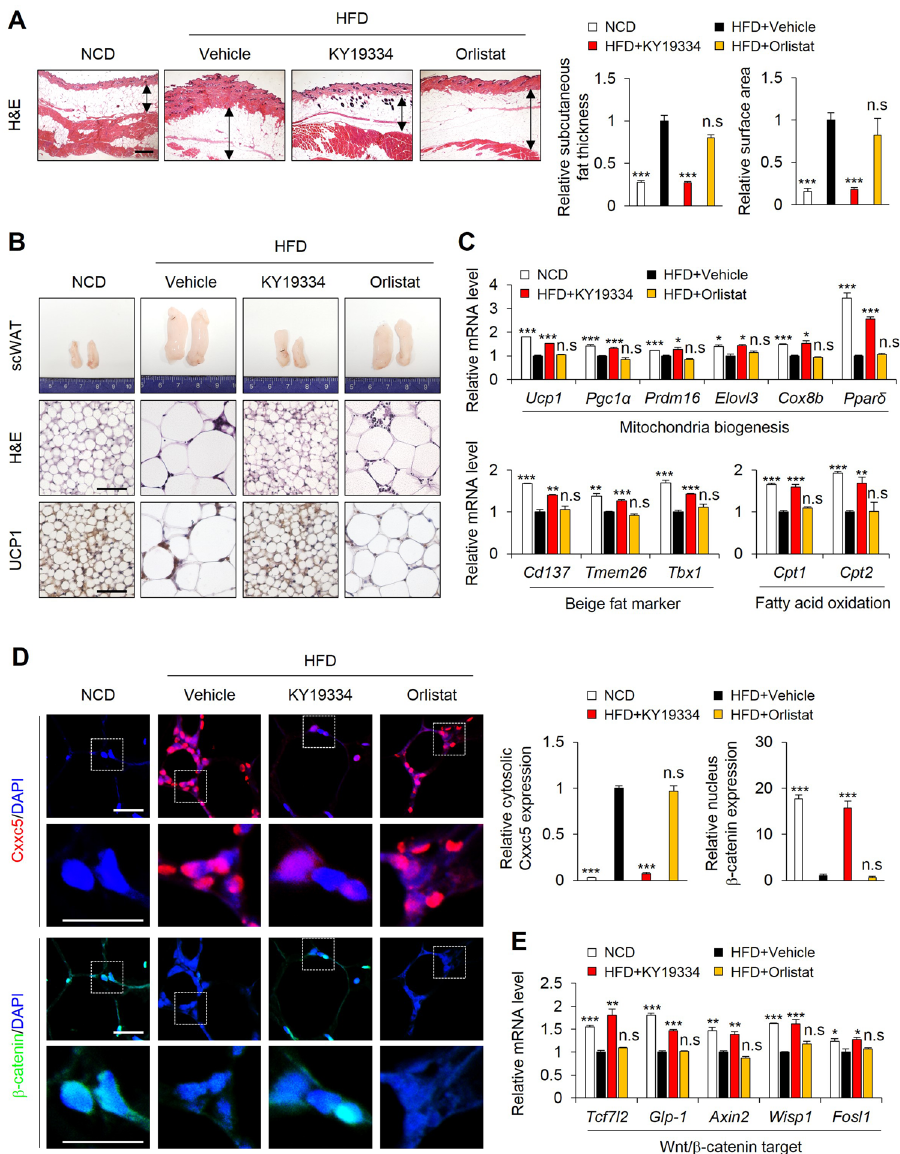
Figure 4. KY19334 treatment reduces adipogenesis and promotes adipose tissue browning in scWAT. C57BL/6 mice fed the NCD or HFD were administered as described in the legend of Fig. 2. ( A ) Representative images of H&E staining of scWAT. Scale bar, 100 µm. Quantitative analyses of subcutaneous fat thickness and adipocyte cell size. ( B ) Representative images of scWAT, H&E staining, and Ucp1 immunohistochemistry of scWAT. ( C ) Relative expression levels of marker genes for mitochondria biogenesis, beige fat and fatty acid oxidation. ( D ) Representative IHC images for Cxxc5 and β-catenin in the scWAT (left panel) and quantitative analyses of IHC staining for CXXC5 and β-catenin (right panel). ( E ) Relative expression levels of marker genes for Wnt/β- catenin target. Scale bar, 100 µm. Results are expressed as mean ± SD., n = 3 per group, * P < 0.05, ** P < 0.01, *** P < 0.001, n.s indicates non-significance with HFD-fed vehicle group. NCD normal chow diet, HFD high-fat diet, scWAT subcutaneous white adipose tissue, Ucp1 uncoupling protein